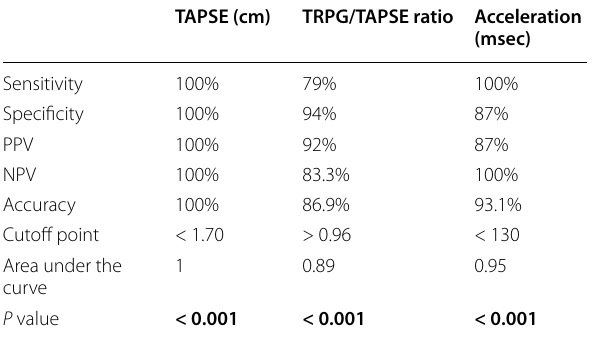
Table 5 New parameters measurements based on troponin level